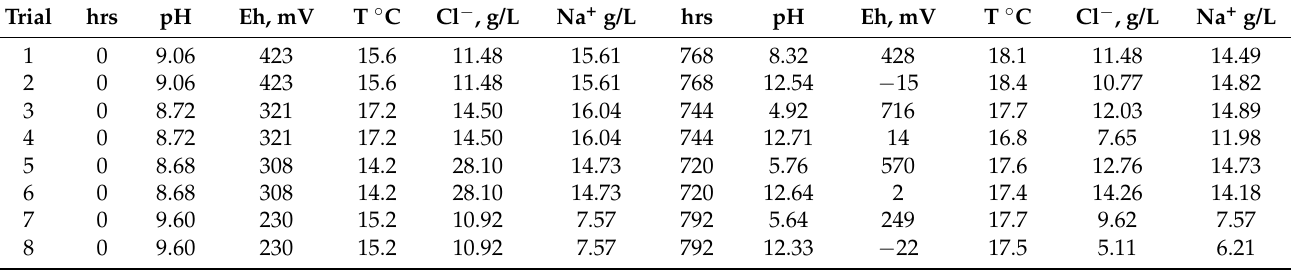
Table A9. Product water, polymer slurry, following >700 h storage for 20 different